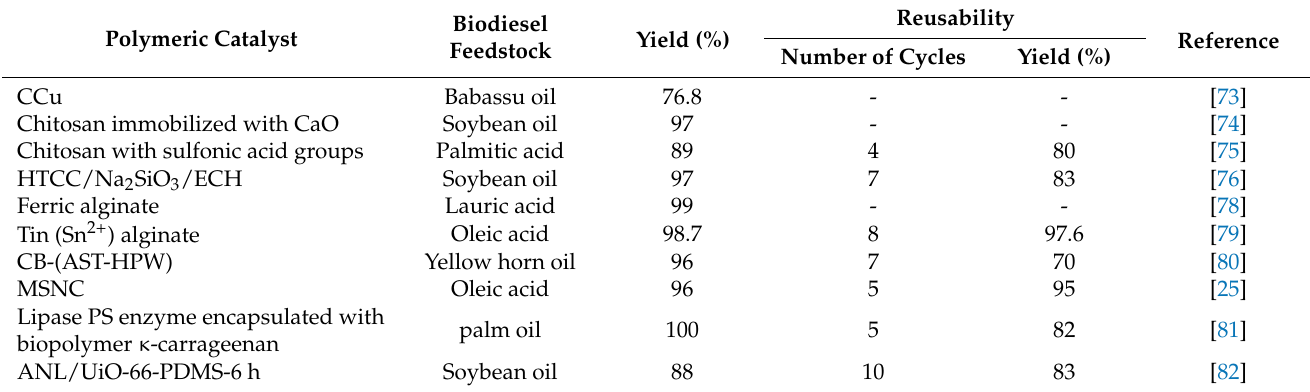
Table 5. Some of the naturally derived polymeric